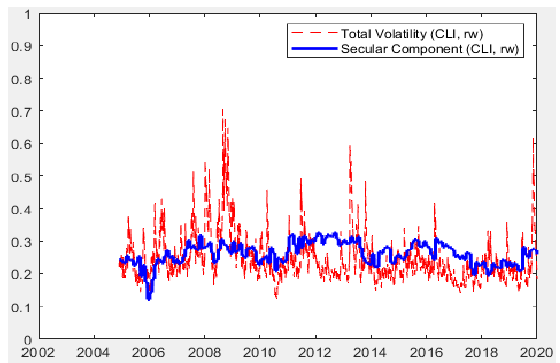
Figure 5. Total Variance and Long-Run Component with Amplitude based CLI. Source: Figures 1–5 are the authors’ own calculations.